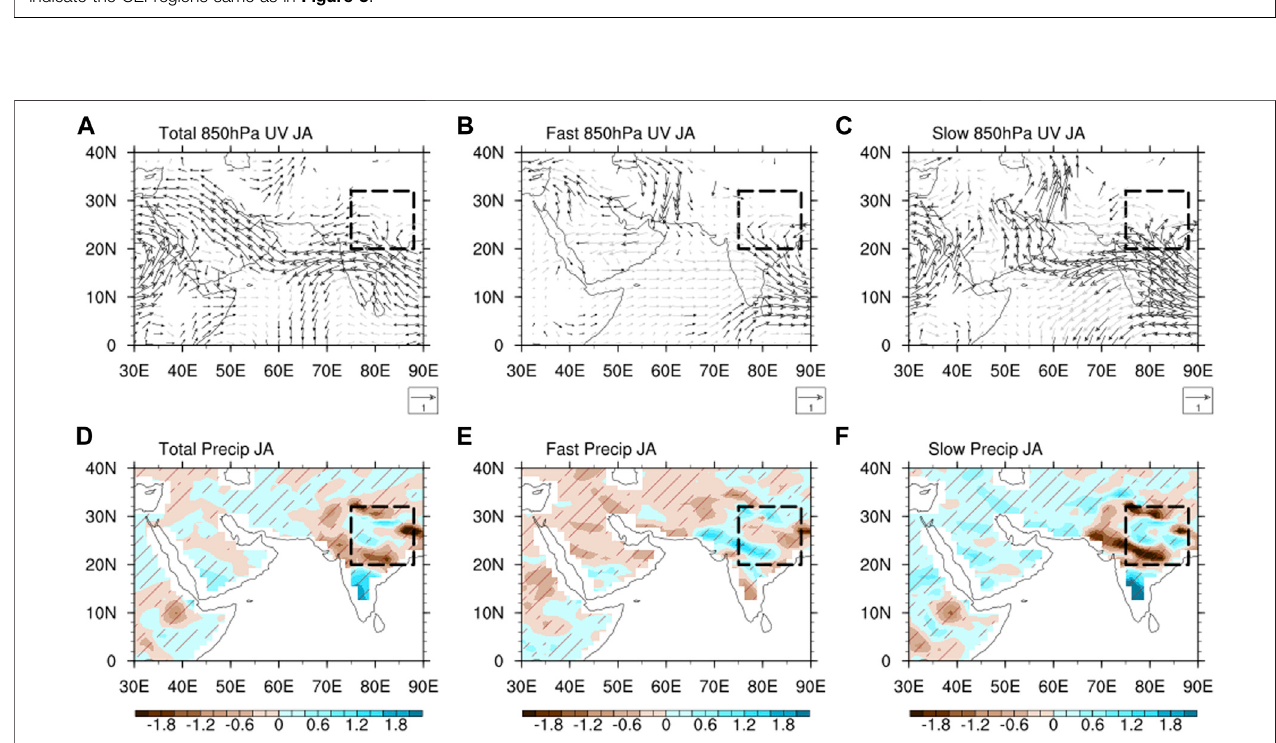
FIGURE 7 | The total [ (A,D) , CMD − CMN], fast [ (B,E) , UMD − UMN] and slow [ (C,F) (CMD − CMN) − (UMD − UMN)] responses of 850 hPa horizontal wind (vectors, A – C , m/s) and precipitation (shaded, D – F , mm/day) to the dust DRE in the late monsoon (July – August). Black (grey) arrows represent the wind vector differences statistically signi fi cant (insigni fi cant) at the 0.1 signi fi cance level. Brown lines represent the precipitation differences statistically signi fi cant at the 0.1 level. Dash boxes indicate the CEI regions same as in Figure 3 .